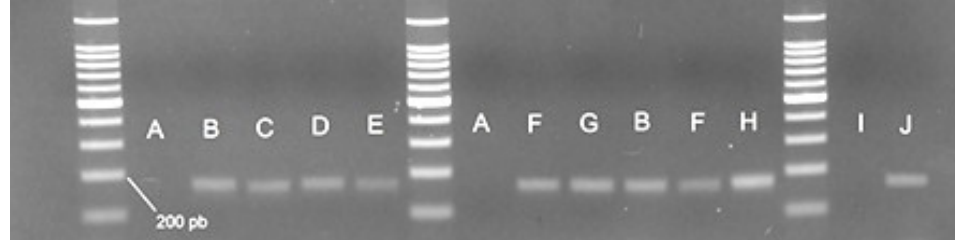
Figure 6. Band patterns given by amplifying the locus A of RP1 with species-specific primers Rut_Bae F/RP1_LocusA R. A— H. huso ; B— A. ruthenus ; C—bester; D—best beluga; E—sterbe; F— A.